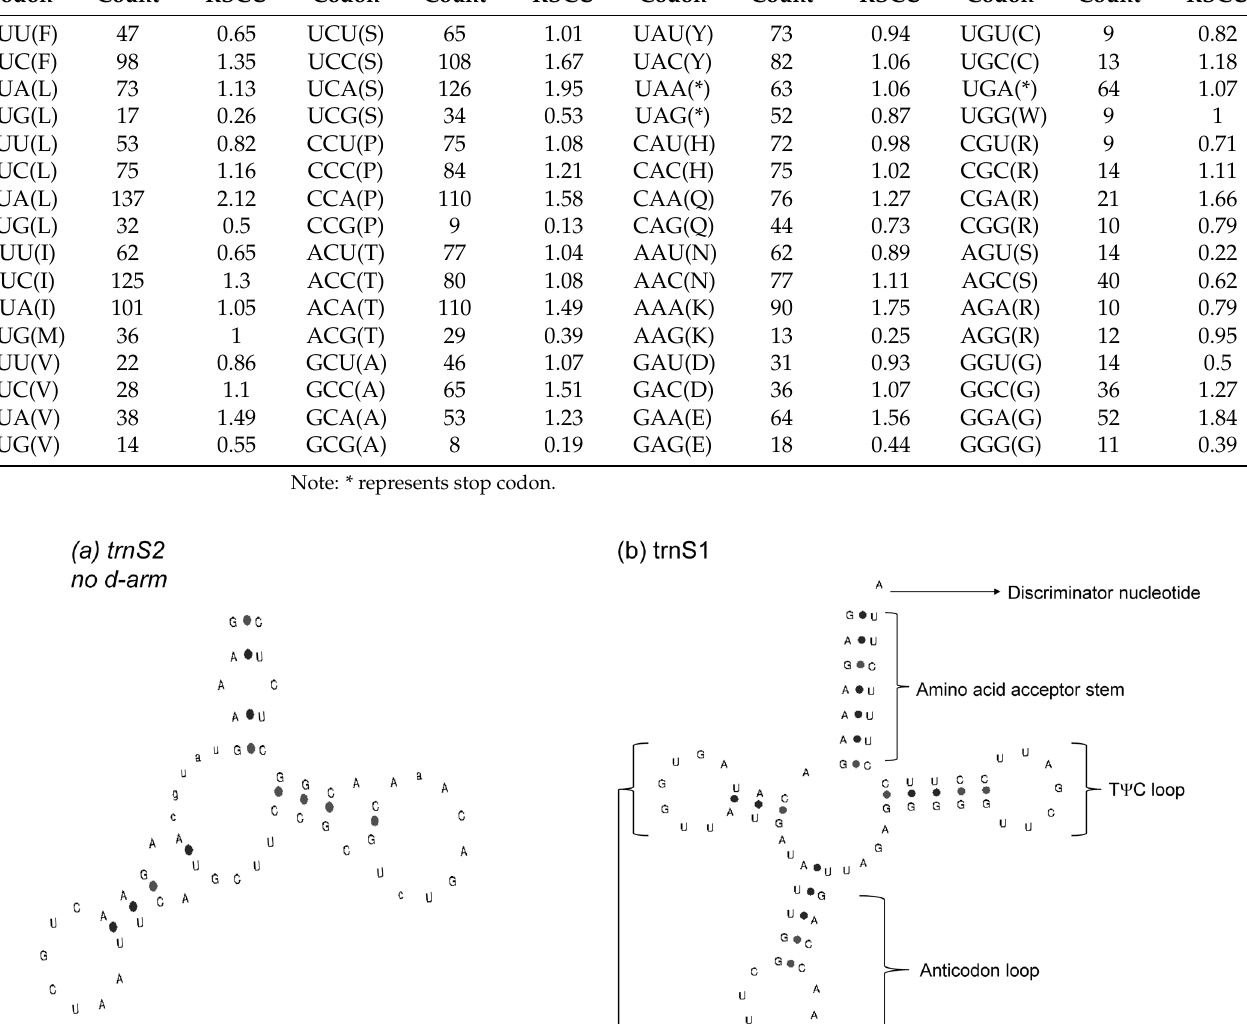
Table 4. Haplotypes and polymorphic sites of the Huaibei Grey donkey mitogenome.